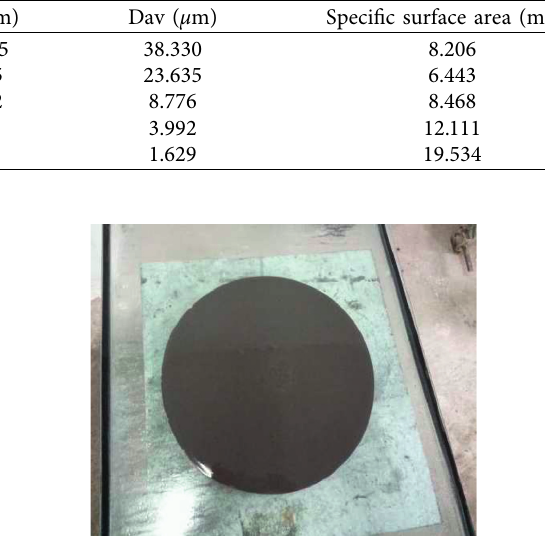
Figure 6: The fluidity of cement paste after 30s.